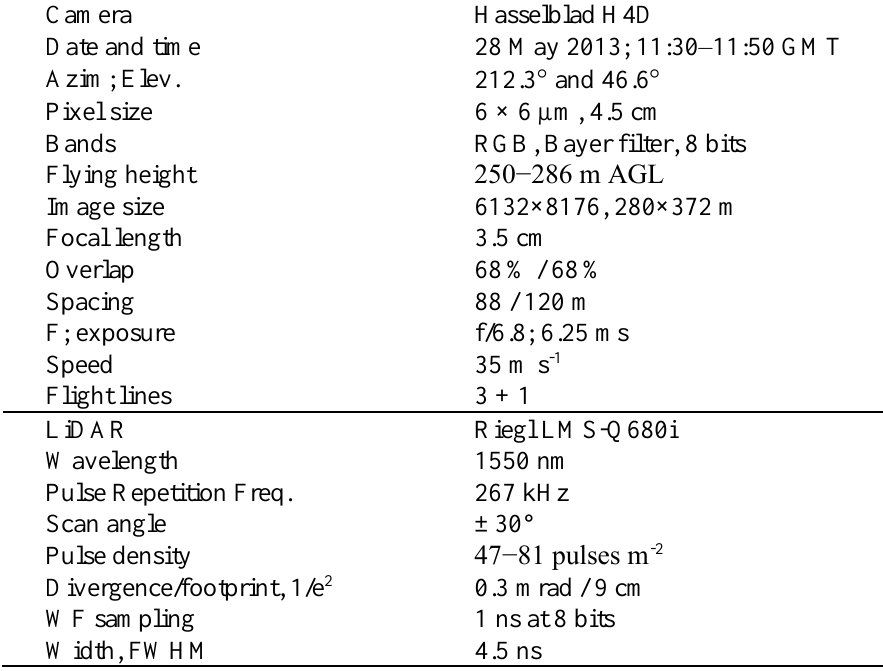
Table 3. Sensor and acquisition parameters for the airborne image and LiDAR